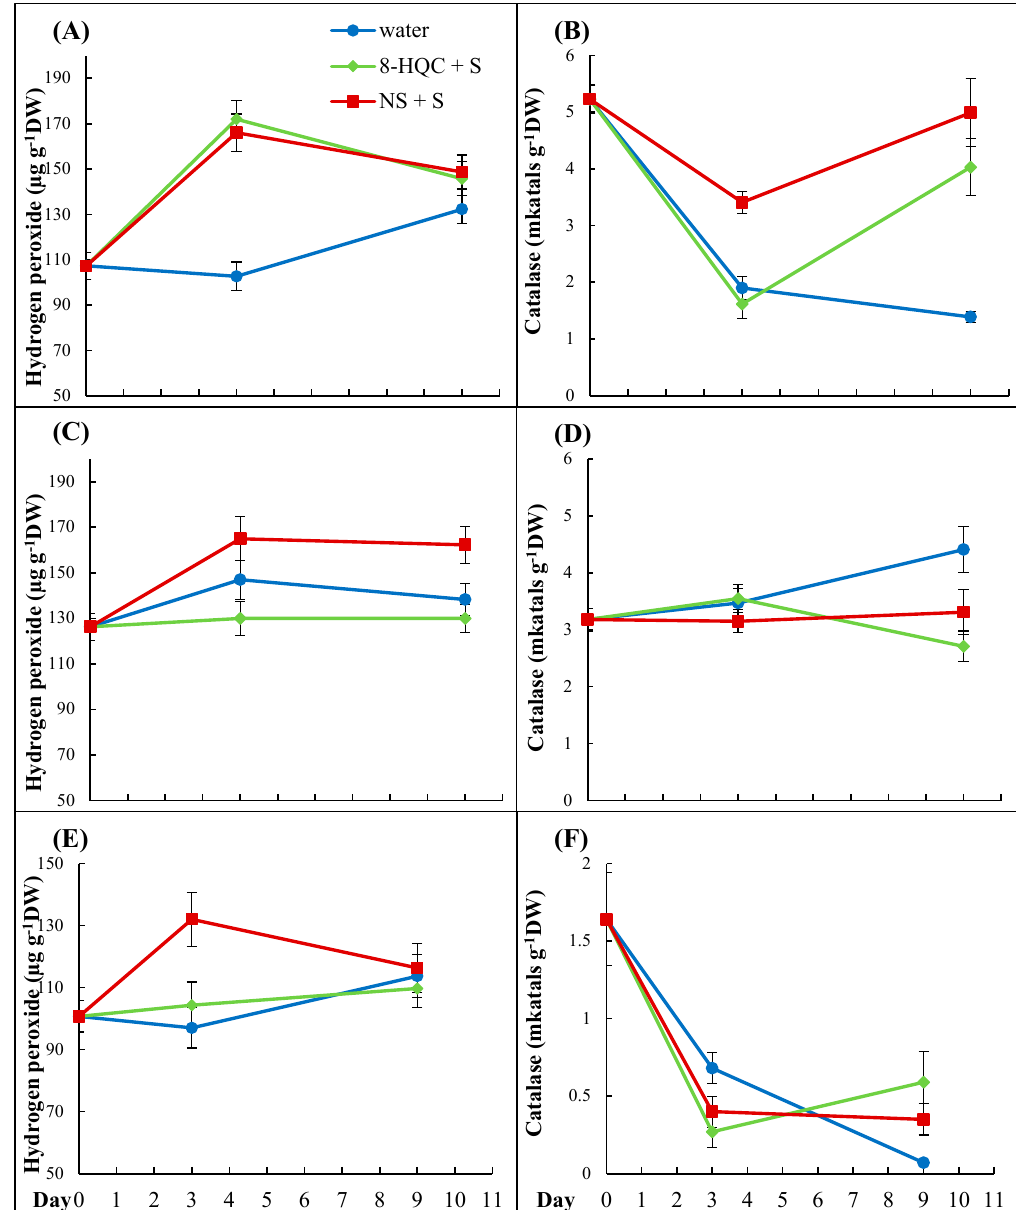
Figure 7. Hydrogen peroxide contents ( A , C , E ) and catalase activities ( B , D , F ) in cut flowers of peony ‘Albert Crousse’ ( A , B ), ‘Gayborder June’ ( C , D ), and ‘Ursynów’ ( E , F ). Values are expressed as the mean ± SD. Vertical bars represent standard deviations of the means.